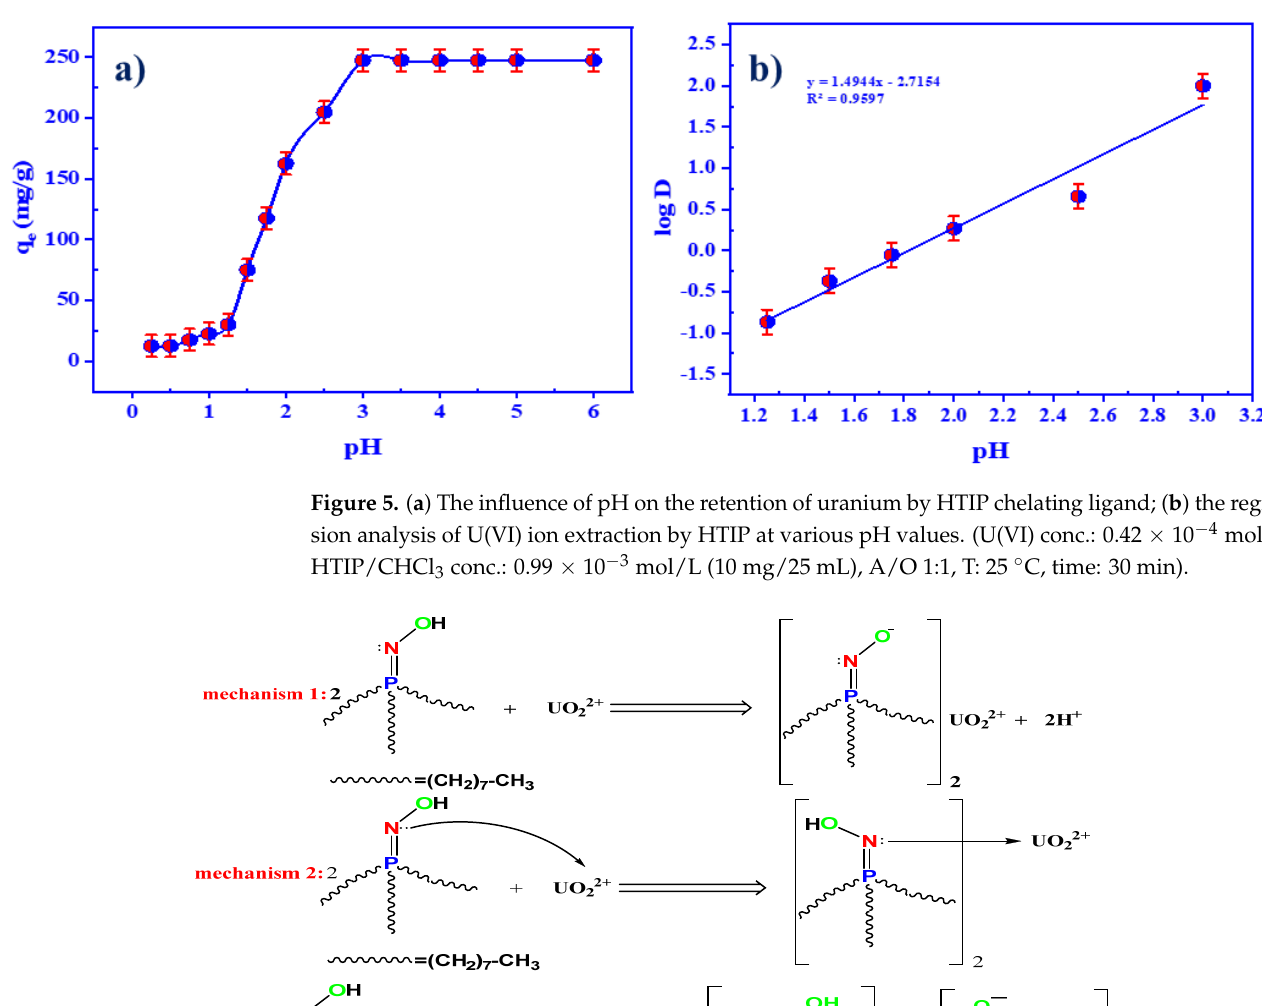
Figure 6. The influence of time on the retention of uranium by HTIP chelating ligand. (U(VI) conc.: 0.42 × 10 − 4 mol/L, HTIP/CHCl 3 conc.: 0.99 × 10 − 3 mol/L (10 mg/25 mL), pH 3.0, A/O 1:1, T: 25 °C). Kinetic studies were used to express the rate of uranyl ion entrapment using HTIP/CHCl 3 , providing crucial information for the design and modeling of the extraction process. Both pseudo first order (PFO) and second order (PSO) kinetic models were em- ployed to identify the mechanism of U(VI) ion entrapment using HTIP/CHCl 3 and the rate constant of the process. The PFO model is presented by the equation below [73]: